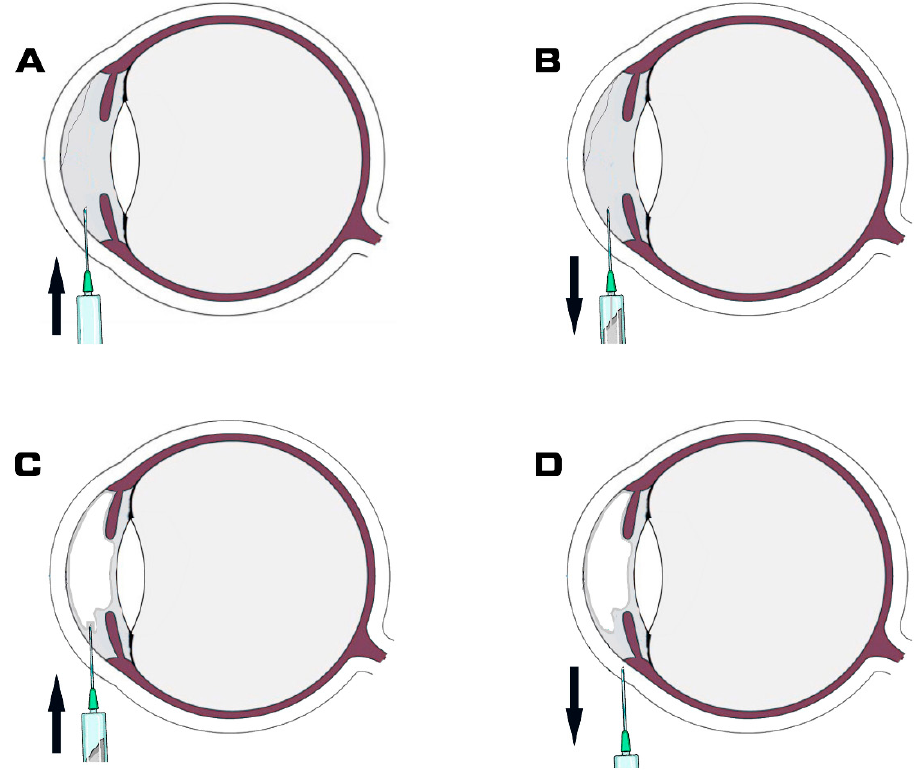
Figure 1. Schematic illustration of intracameral air bubble injection. ( A ) Syringe needle was inserted from limbus area into anterior chamber. ( B ) Syringe was retracted and subsequently aqueous humor was suctioned. Approximately 150 µL of aqueous humor outflow into syringe. ( C ) Air was injected into the anterior chamber until there was approximately two-thirds air fill of the total anterior chamber volume. ( D ) Pulling the syringe needle from cornea. Arrow represent the direction of the needle. Parameters evaluated were visual acuity, IOP, corneal clarity, and DMD on slit-lamp examination. DMD status was observed after the absorption of the air bubble using slit-lamp examination and AS-OCT. Associated complications were also recorded.